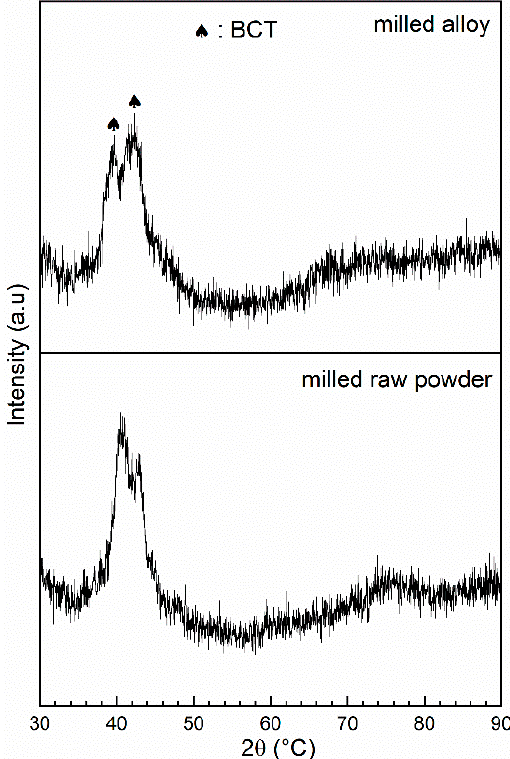
Figure 10. XRD patterns of the milled raw powder and milled alloy in the hydrogenated state.